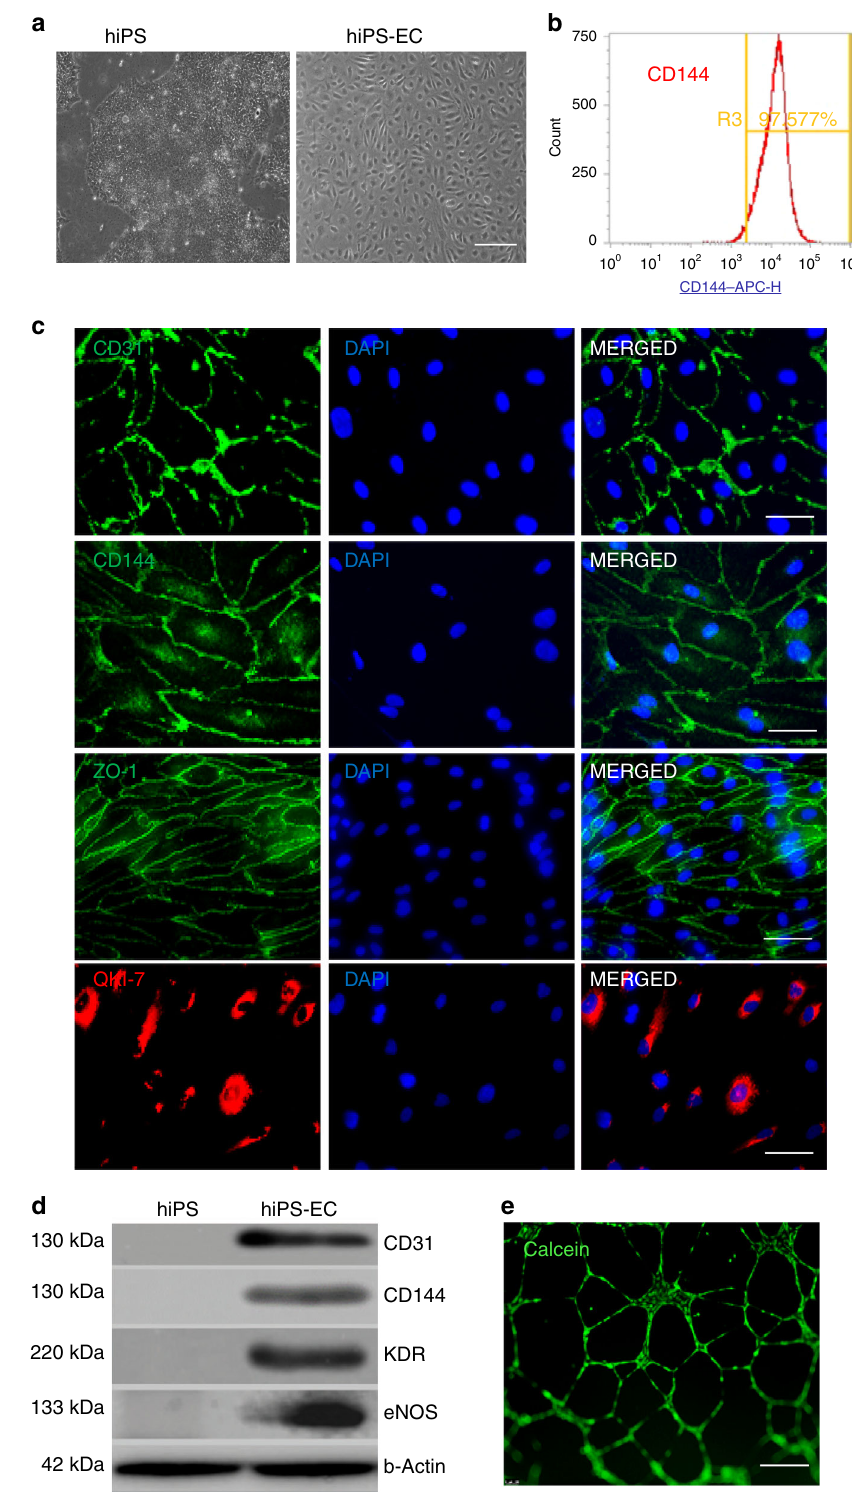
Fig. 3 Human iPS cells differentiation toward ECs. Morphology of hiPSCs and their EC differentiated counterparts are shown by bright fi eld microscopy. Scale bar: 50 μ m ( a ). Flow cytometry showed the pure population of hiPS-derived ECs after MACS selection using CD144 magnetic beads ( b ). Immuno fl uorescence confocal image showing that the differentiated ECs expressed the EC-speci fi c markers CD31, CD144, and ZO-1 localizing to cell – cell junction. QKI-7 displayed perinuclear cytoplasm localization. Scale bar: 25 μ m ( c ). The expression of EC marker proteins CD31, CD144, KDR, and eNOS was shown by western blot ( d ). hiPS-ECs formed tube structure indicating their angiogenic capacity. Scale bar: 200 μ m ( e ). Data are from n = 3 representative images. Source data are provided as a Source data fi